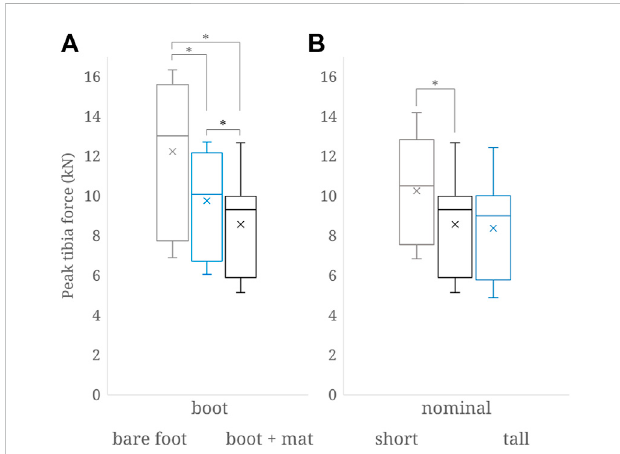
FIGURE 3 Comparison of peak tibia force distributions between (A) original, baseline model and mitigation represented by the combat boot (data from (Rebelo et al., 2021)) and the combat boot and the IMPAXX fl oor mat; (B) short, tall, and the nominal stature all with a combat boot and the fl oor mat. Statistical signi fi cance ( p < .05) using the Student ’ s t-test between the distributions is noted with the